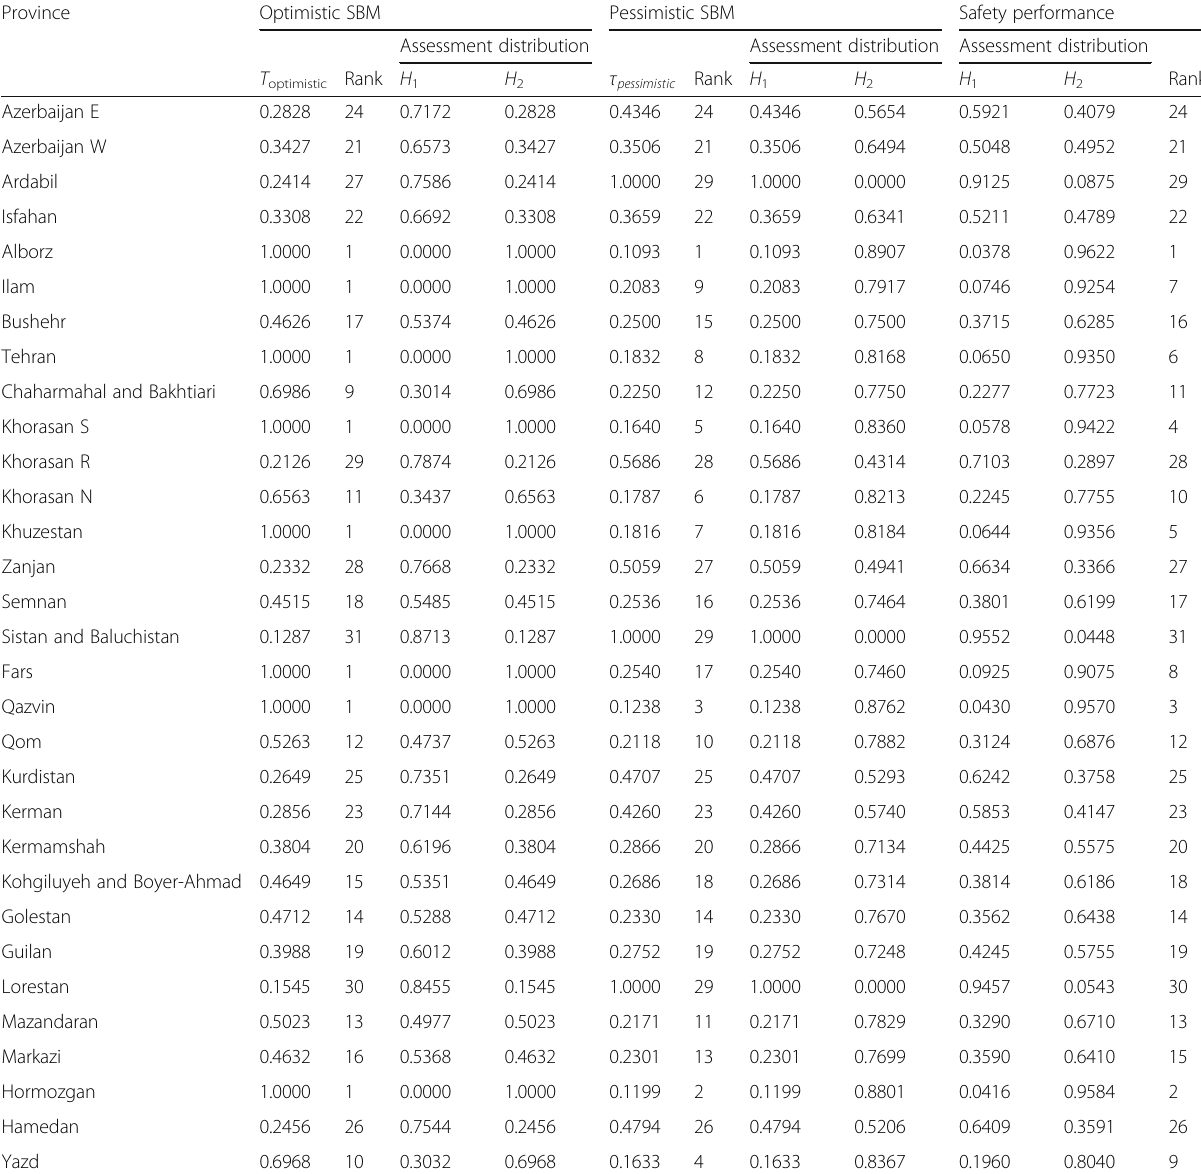
Table 3 Efficiency results for the 31 Iranian provinces in terms of road safety performance for the year 2014 Province Optimistic